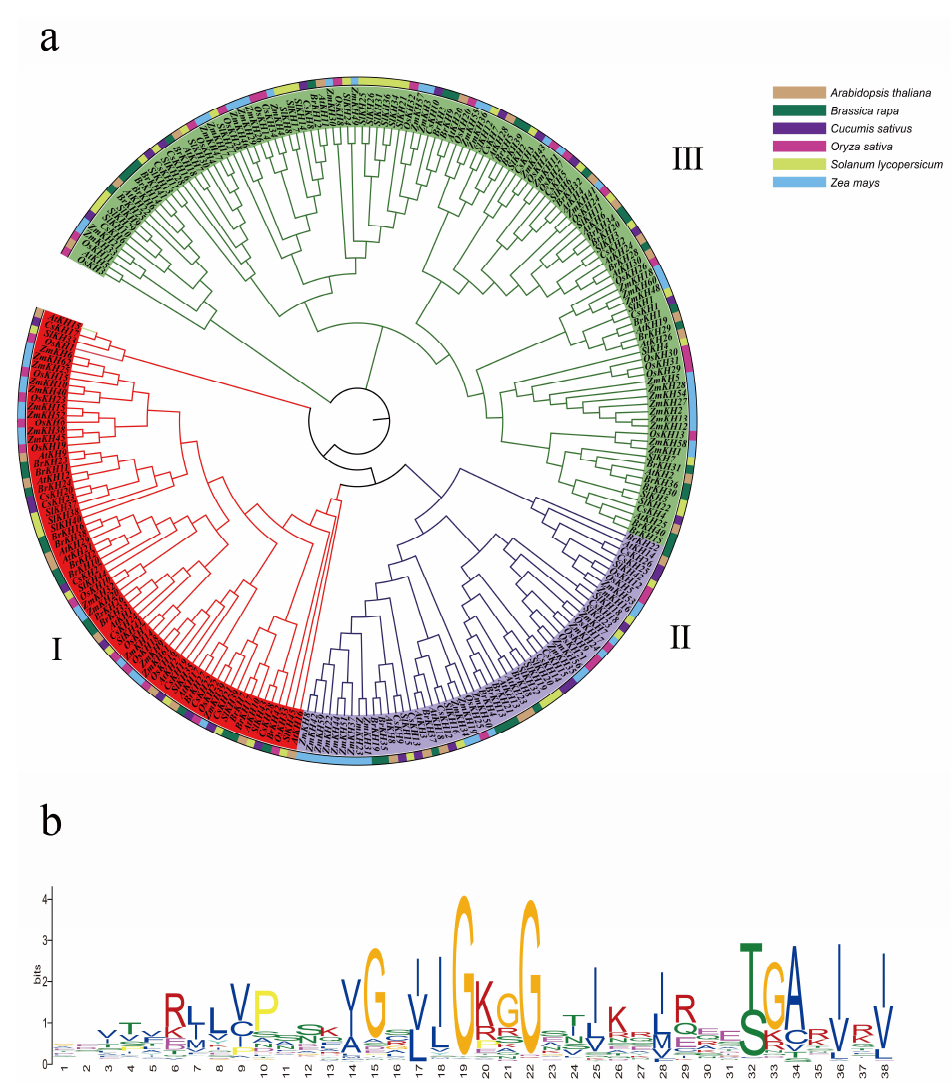
Figure 2. The phylogenetic tree and the main motif of KH family genes in six species. ( a ) The phylogenetic tree was constructed by hypothetical KH domain genes in six species. The outer layer showed the KH domain genes from six different species in six different colors, and three colors of the inner layer were used to mark the three subgroups. ( b ) The main motif of the identified KH genes.